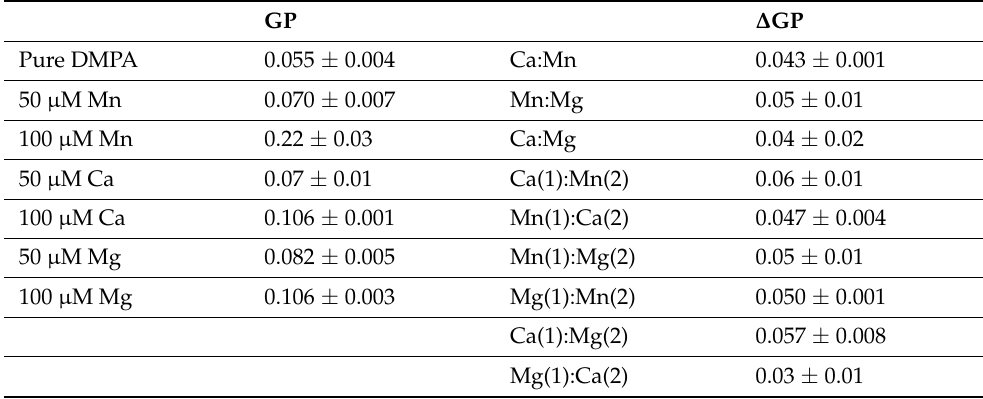
Table 3. Tabulated GP and ∆ GP values of DMPA lipid with Mn, Ca, Mg and metal